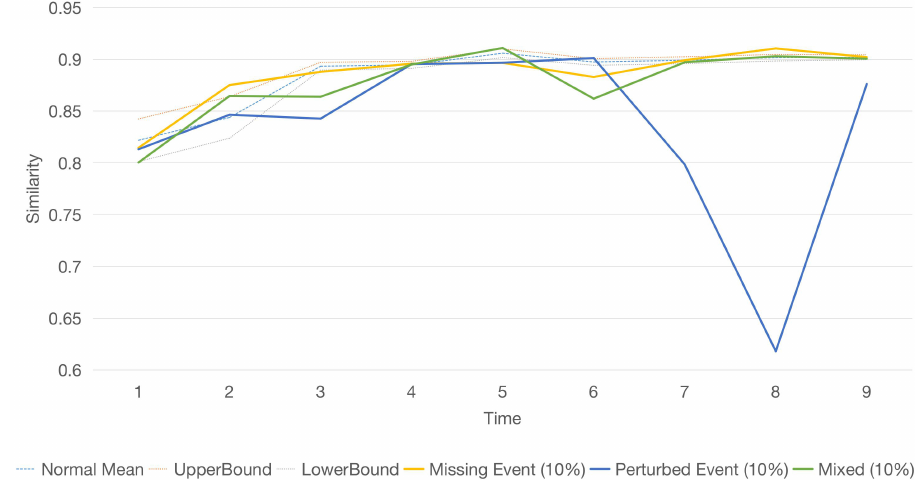
Figure 14. Detection of an anomaly with 10% occurrence probability. Anomaly occurrence probability more than 10% will show obvious deviation in the Z-score, especially for mixed